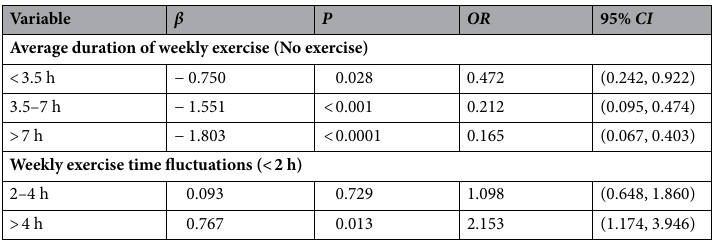
Table 2. The influence of regular exercise of stroke survivors on recurrence. After adjusted gender, age, marital status, education, occupation, income, lesion side, hypertension, diabetes, hyperlipidemia, heart disease, peripheral vascular disease, smoking, drinking, BMI, mRS, medication compliance and family history of